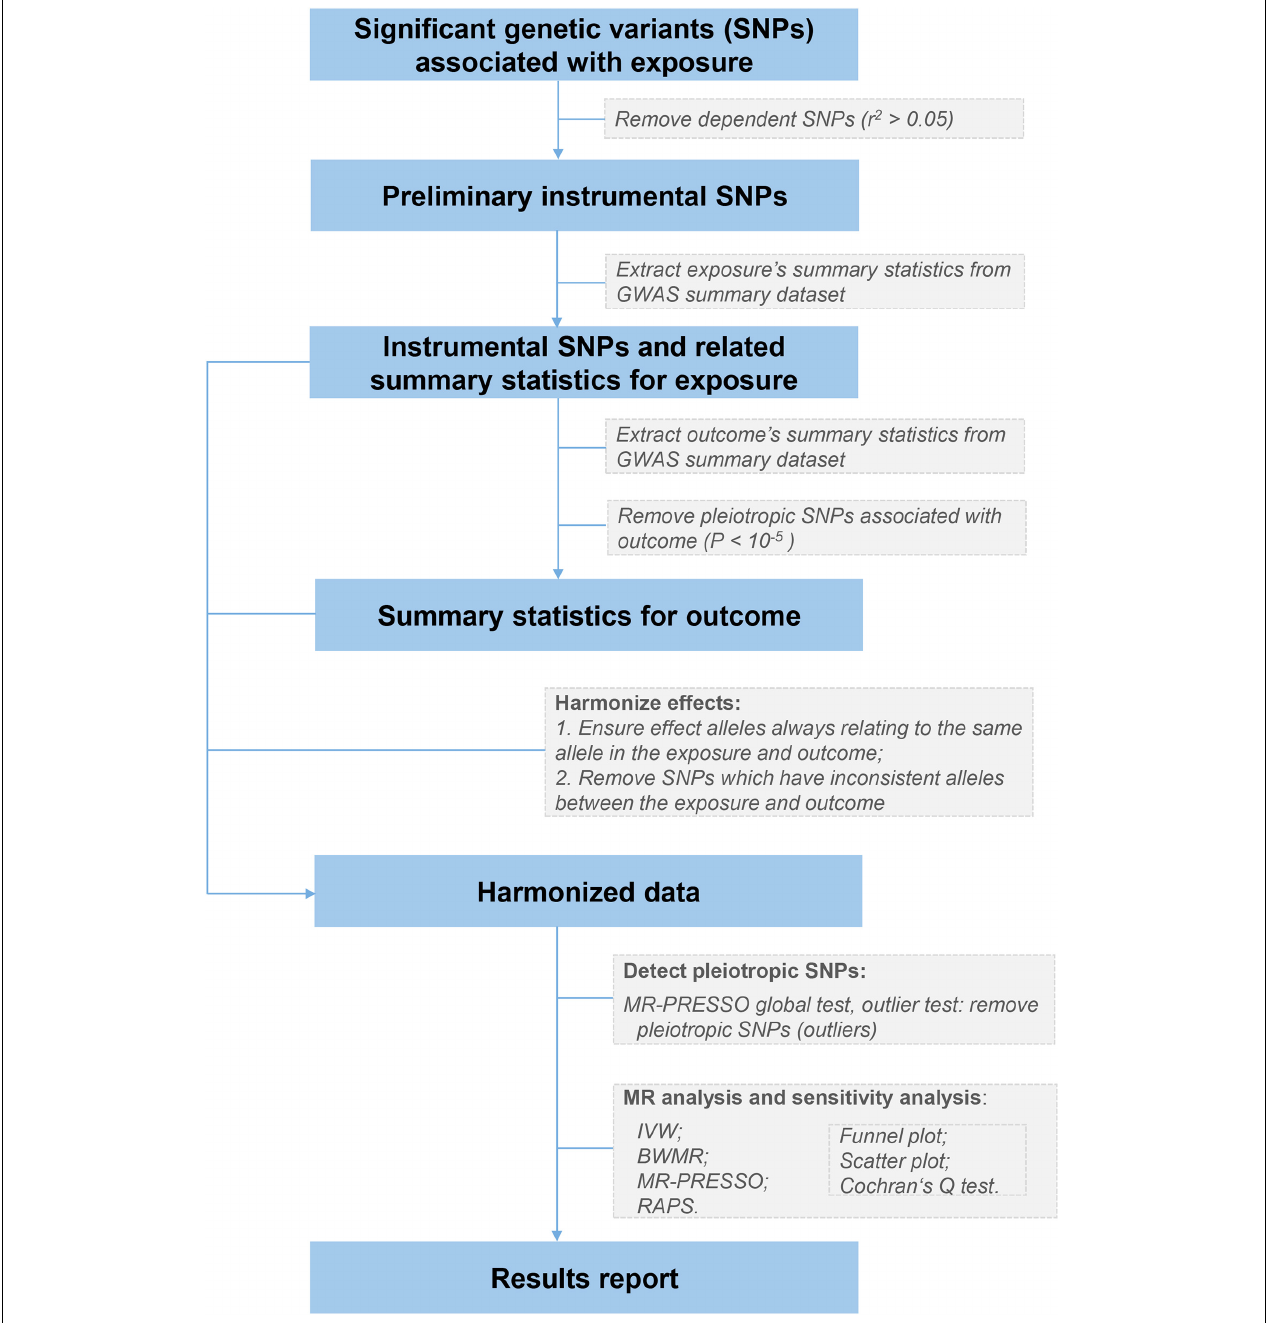
FIGURE 1 | The analysis flowchart of this study. IVW, the inverse variance weighted method with a multiplicative random effects model; BWMR, the Bayesian weighted Mendelian randomization method; MR-PRESSO, the Mendelian randomization pleiotropy residual sum and outlier method; RAPS, the robust adjusted profile score method.